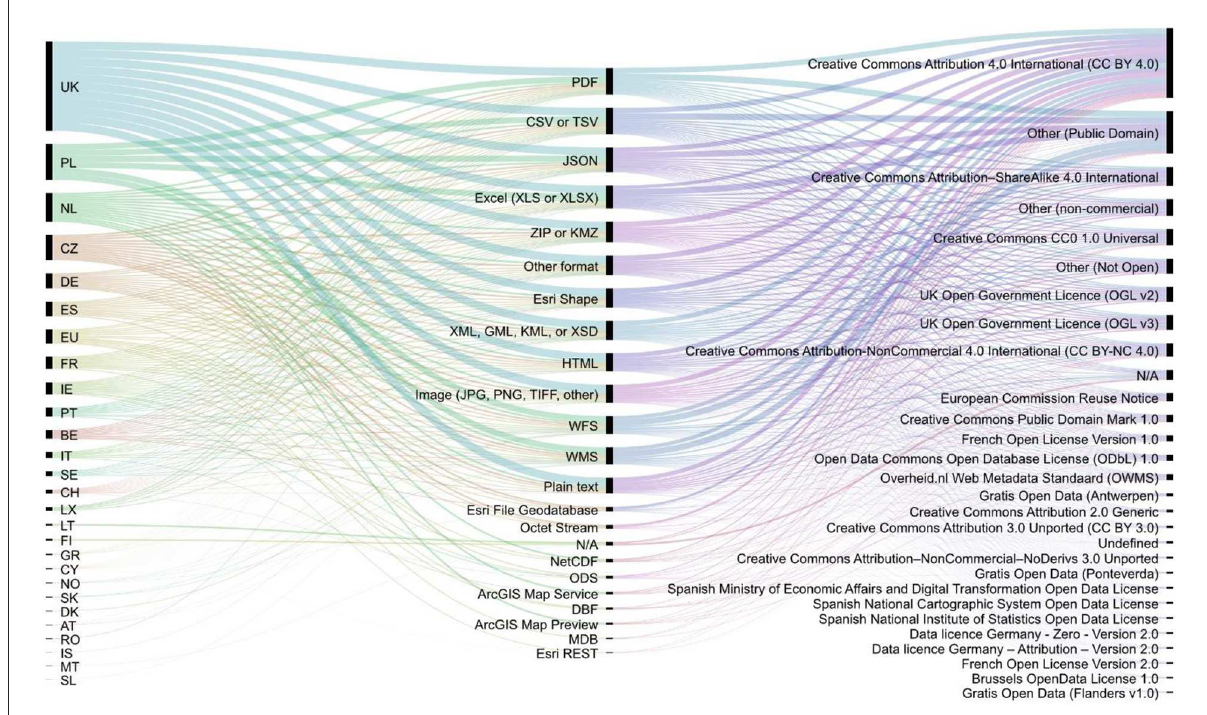
FIGURE1 Data Europa.eu overview of water open datasets in 2021.